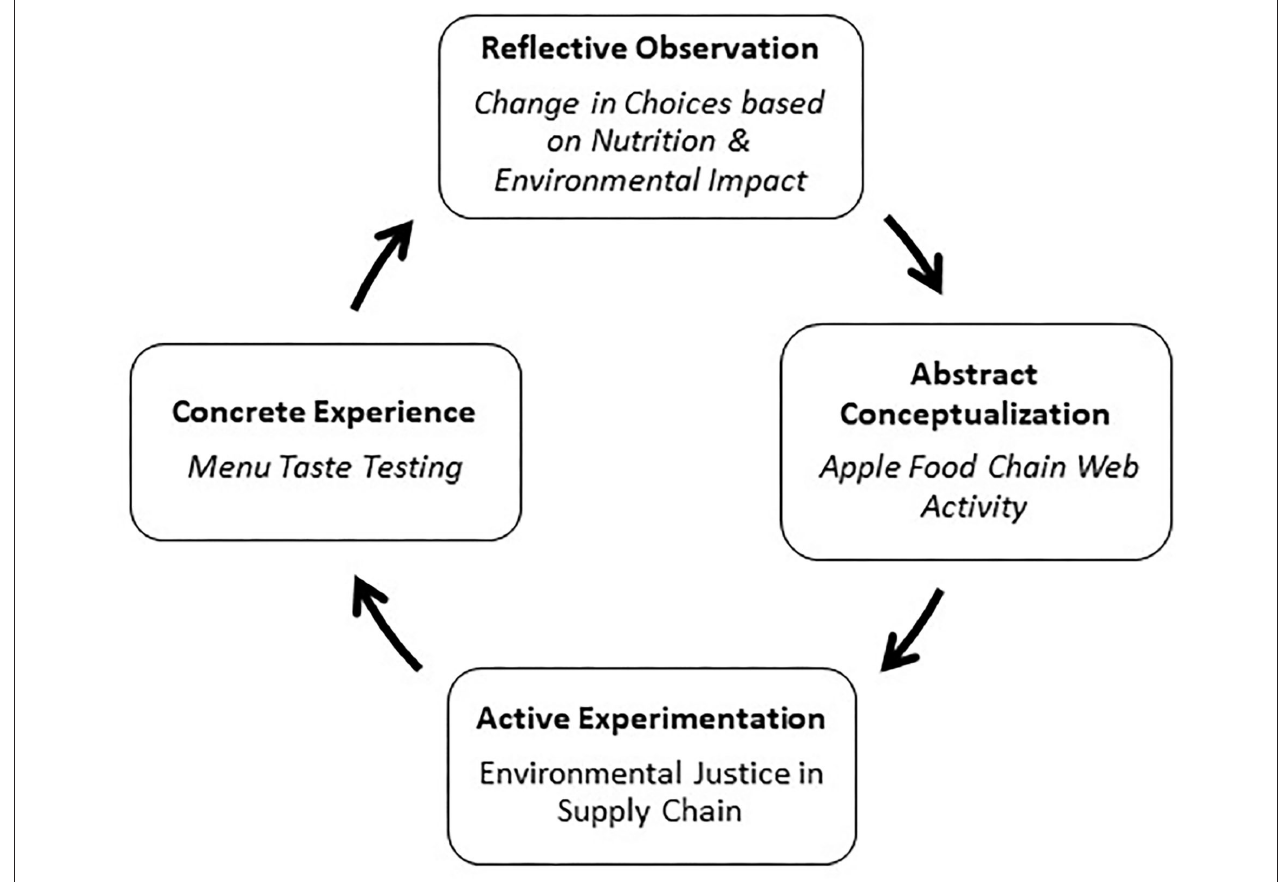
FIGURE 1 | Kolb’s Cycle of Experiential Learning to create in-class